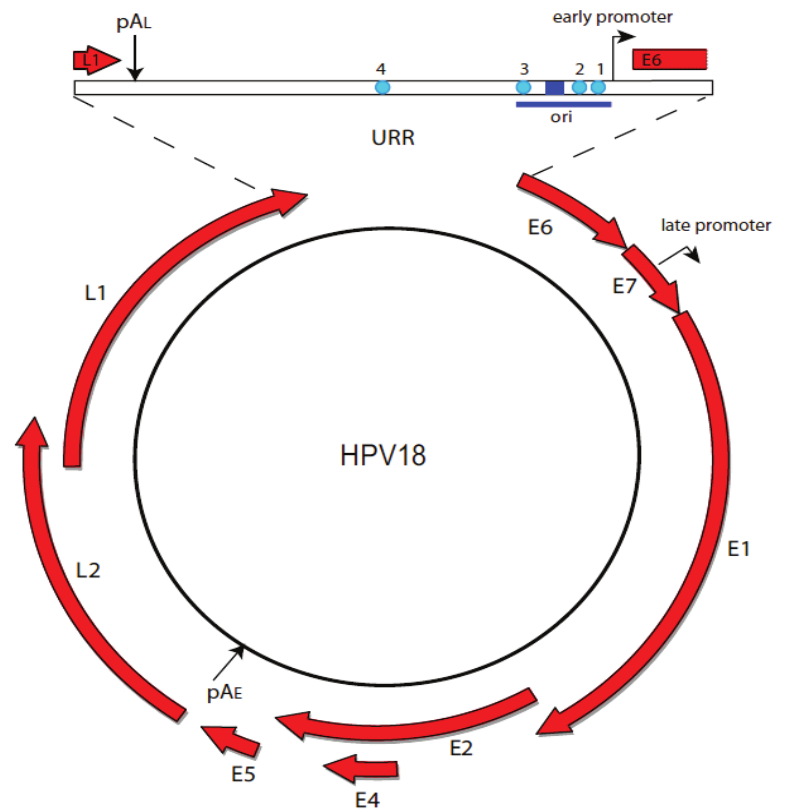
Figure 1. HPV18 genome. The circular dsDNA genome of HPV18 (7,857 bp) is shown. Viral open reading frames are depicted as red arrows. The URR (upstream regulatory region) is expanded to show transcription and replication regulatory elements. Binding sites for the E2 protein (cyan circles) and the E1 binding site (blue rectangle) are shown. The early promoter and replication origin (ori) are